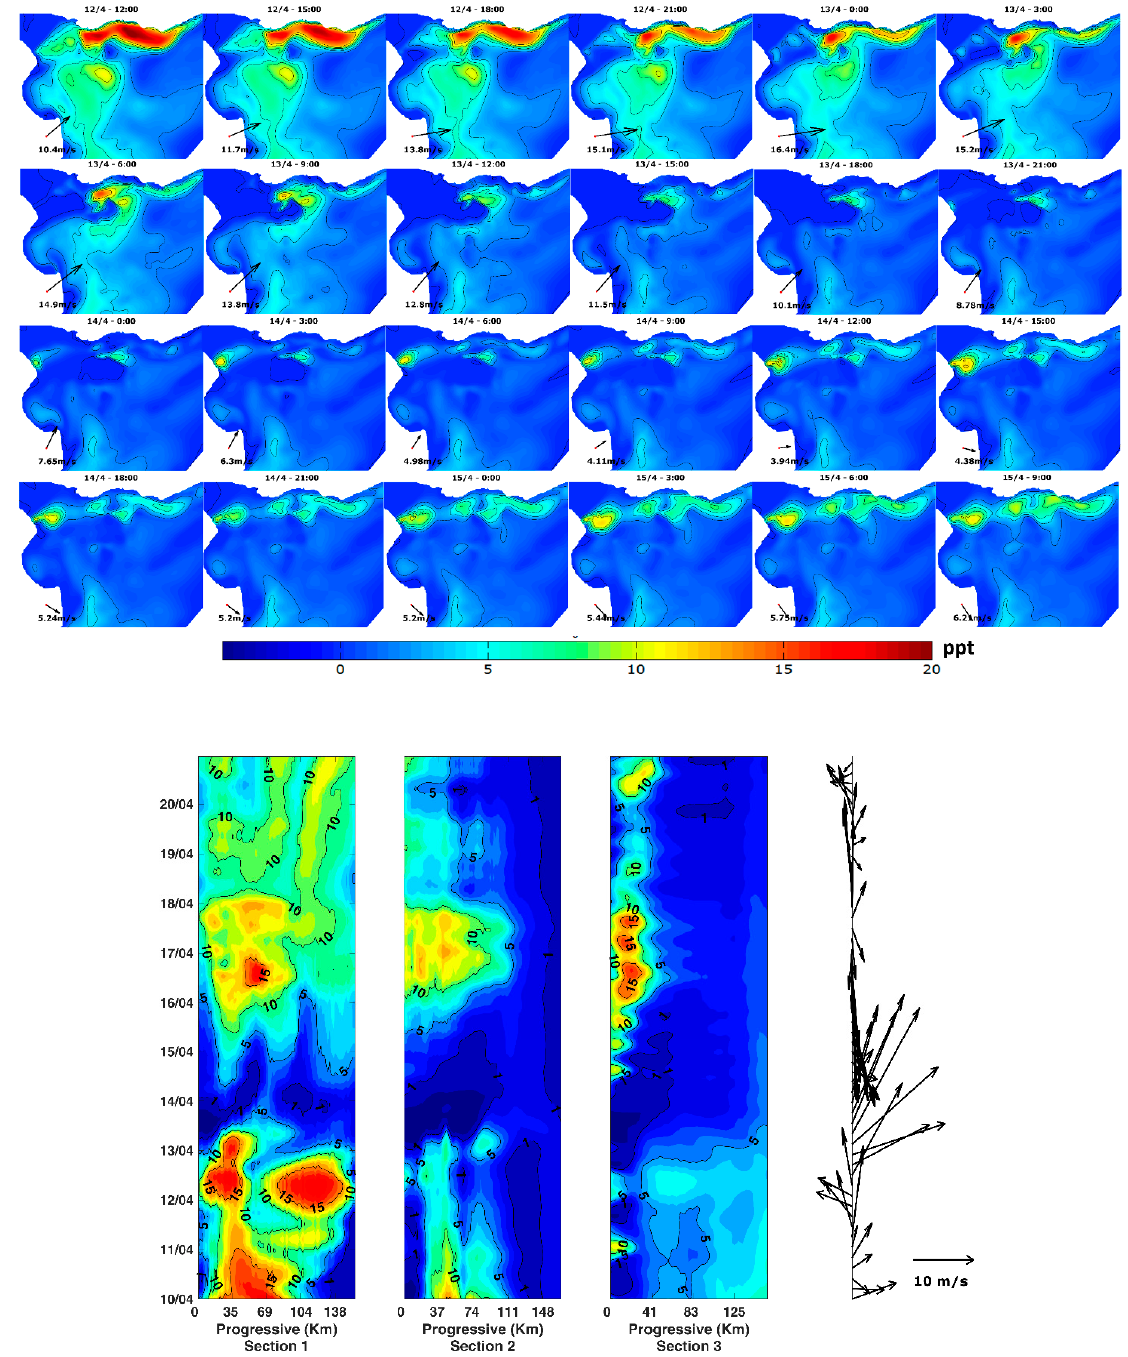
Figure 8. Stratification for a storm with main wind direction from the southwest, which occurred in April 2014. Upper panel: temporal evolution of the stratification field (ppt; time step: 3 h). Time increasing from left to right and upper to lower panels. All maps are in geographic coordinates between Lat ( − 36.9, − 34.7) and Long ( − 57.4, 54.2). Lower panel: Hovmoller diagram along longitudinal sections (Figure 7); wind evolution on the right. Y-axis shows the date (dd/mm). Complementing the stratification analysis for the southwest storm, the bottom and surface salinity fields before the storm, a few hours after the peak of the storm, and two